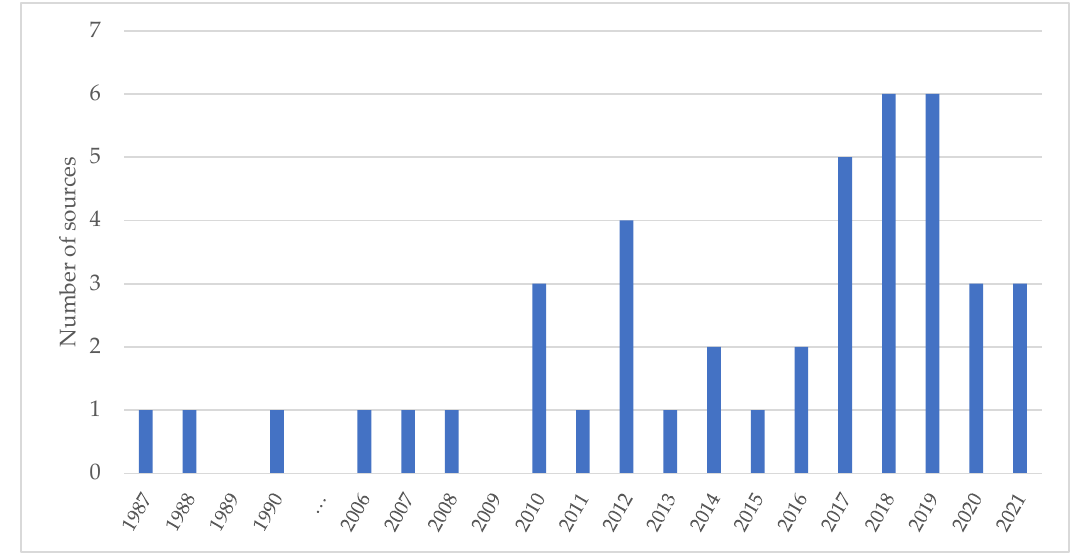
Figure 2. Number of sources by publication year.